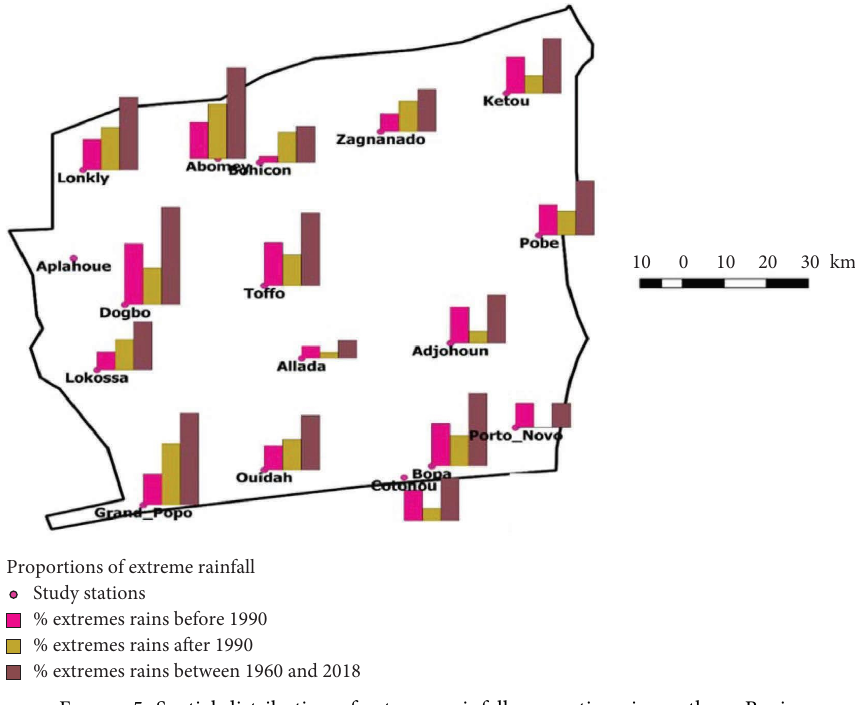
Figure 5: Spatial distribution of extreme rainfall proportions in southern Benin.